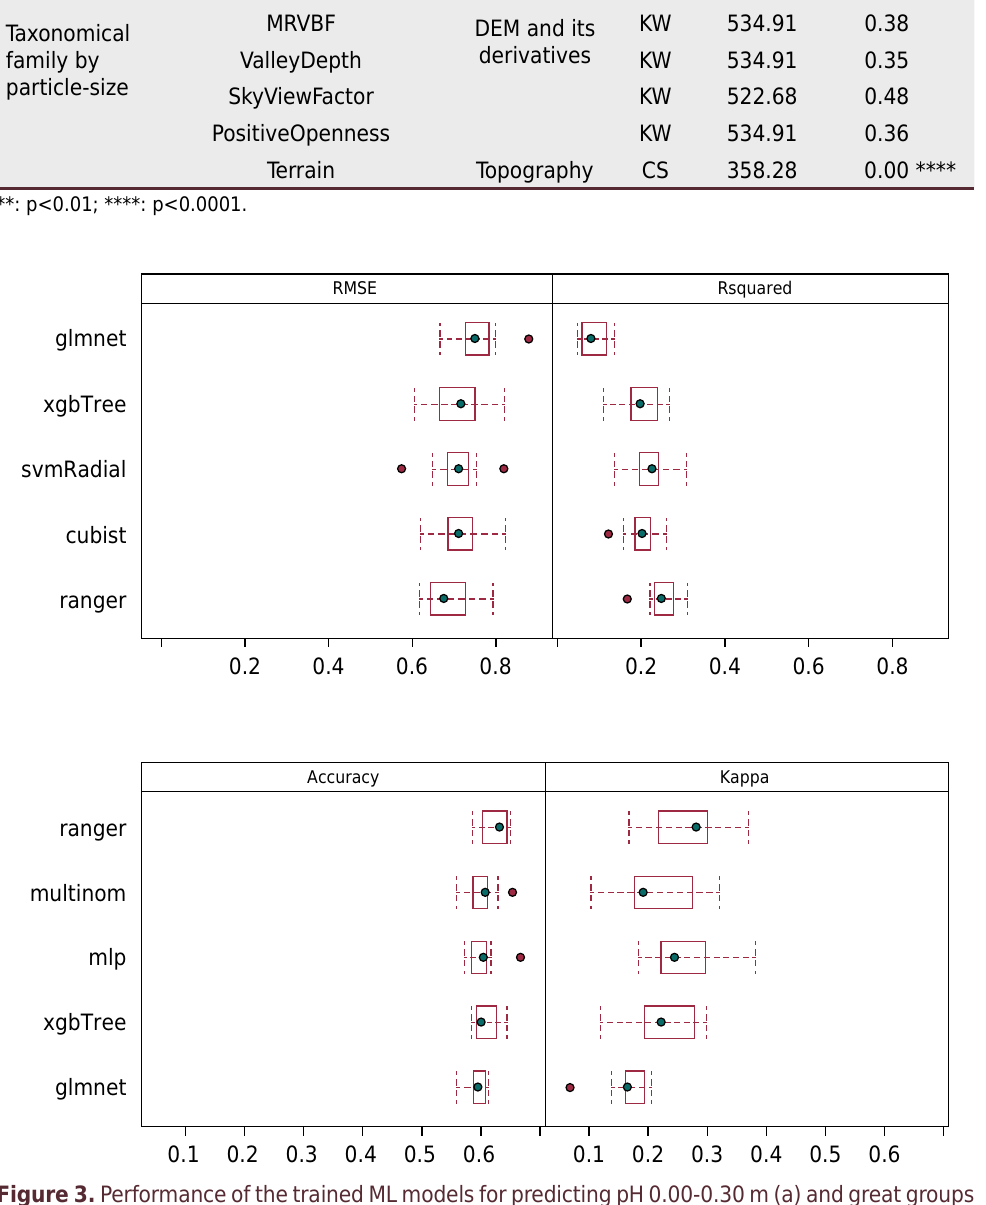
Figure 3. Performance of the trained ML models for predicting pH 0.00-0.30 m (a) and great groups (b). The random forest (ranger) obtained the best performance according to the main metrics, RMSE and Accuracy, used for quantitative and categorical variables,